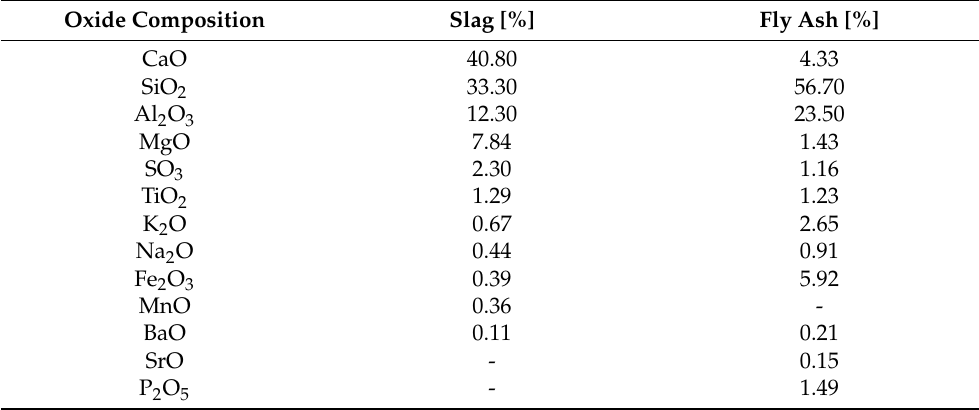
Table 2. Oxide compositions of precursors (wt.%)